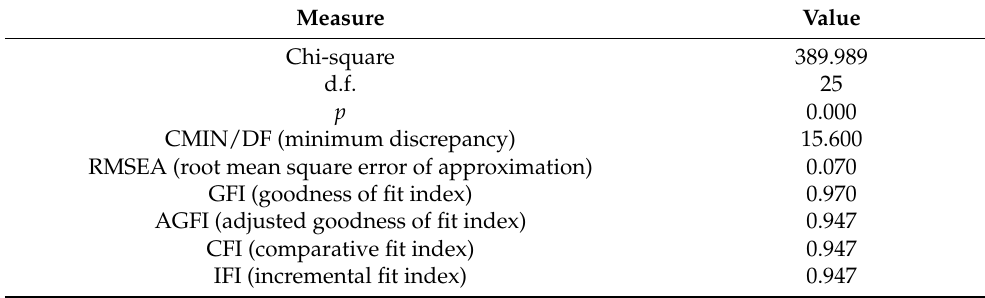
Table 6. Structural equation model—characteristics and quality measures.